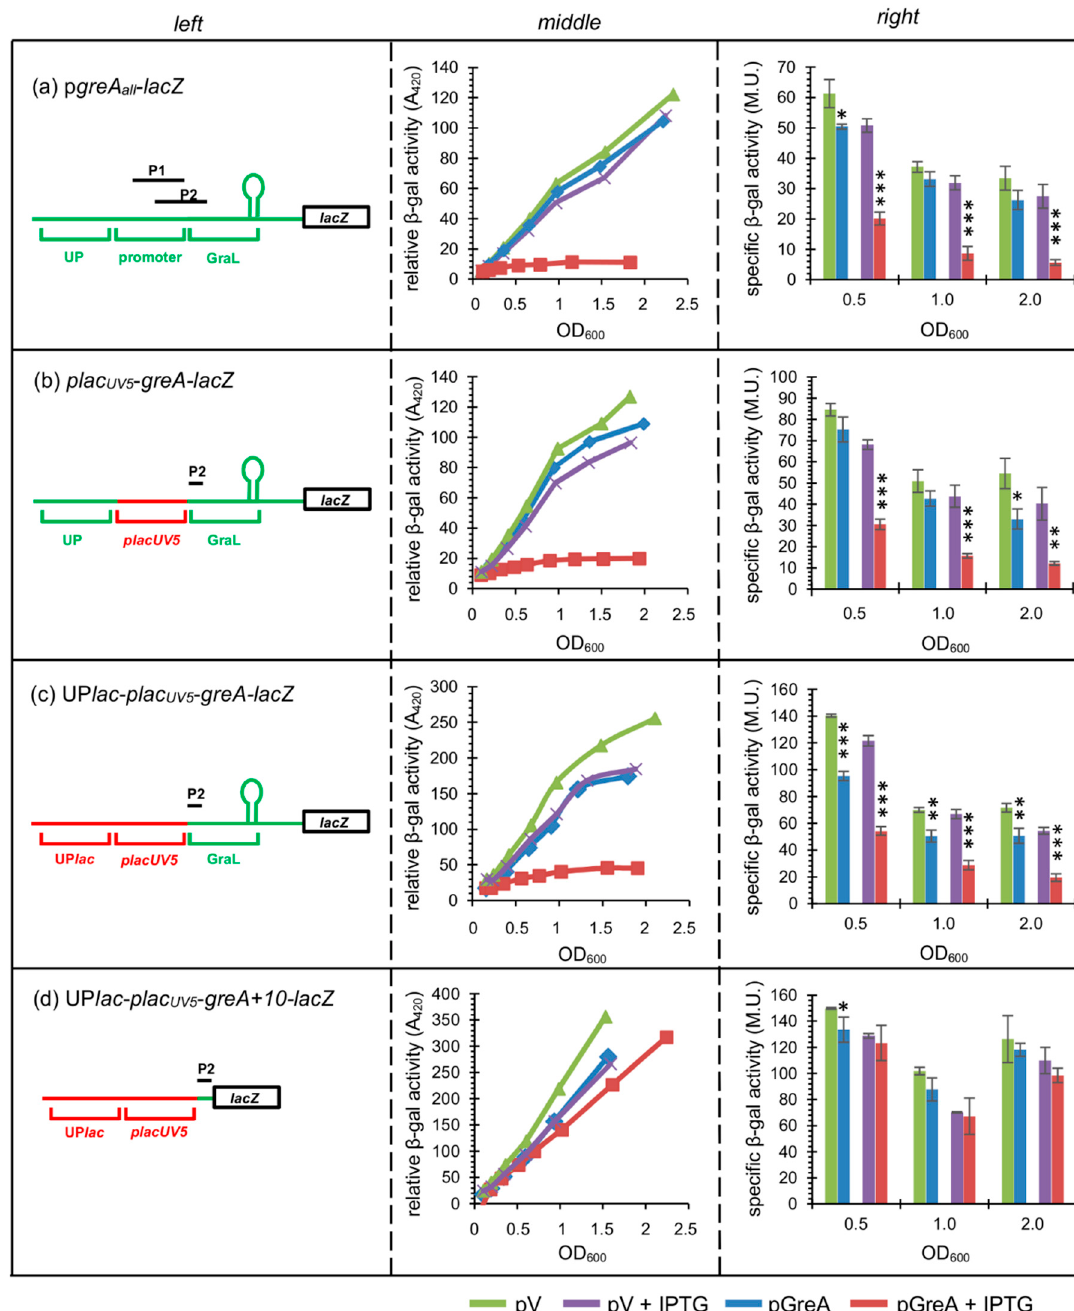
Figure 3. The promoter region does not determine autoregulation exerted by GreA. Assessment of β -galactosidase activity in strains overproducing GreA from a multicopy plasmid (pGreA) for: ( a ) p greA all - lacZ; ( b ) p lac UV5 - greA - lacZ; ( c ) UP-p lac UV5 - greA - lacZ ; ( d ) UP-p lac UV5 - greA + 10 - lacZ (negative control) fusions. Wt ∆ lacZ strains carrying appropriate single copy fusions were grown in LB at 32 ◦ C with aeration; if present, isopropyl- β - d -thio-galactopyranoside (IPTG) was added at OD 600 ~ 0.1 to 1 mM; pV—vector control. Left panels—schematic representation of the lacZ fusions employed; hairpin symbolizes the GraL terminator; not drawn to scale. Middle panels—di ff erential plots of β -galactosidase activities vs . OD 600 , following transcriptional activity throughout growth. The slope of each curve corresponds to the specific activity of β -galactosidase. Right panels—specific β -galactosidase activities assessed for each strain at OD 600 ~ 0.5, 1.0, and 2.0 (experiment was done in triplicate). Error bars represent S.D. For clarity, p -values calculated for pV vs . pGreA, and pV + IPTG vs . pGreA + IPTG are only shown. * p < 0.05, ** p < 0.005, *** p < 0.0005.